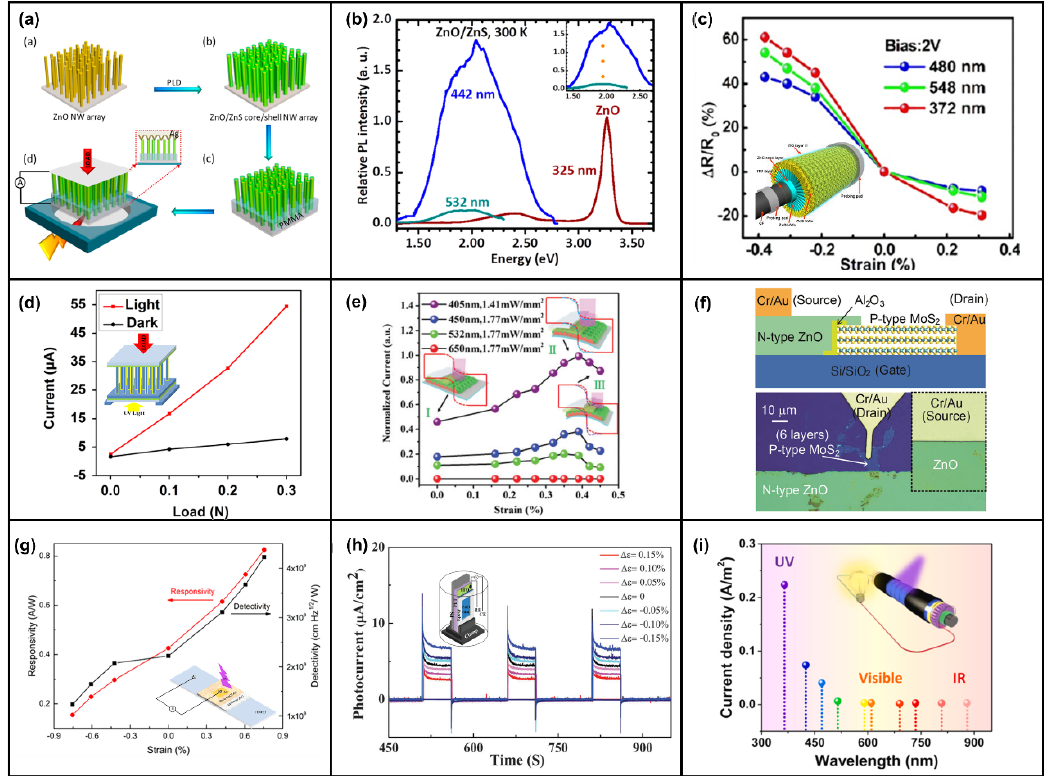
Figure 6. Device structure and characterization of photodetectors formed by Si/organic or other inorganic materials. ( a ) Schematic illustration of the ZnO/ZnS CS NW photodetector fabrication process. ( b ) Room-temperature PL for ZnO/ZnS core/shell NWs collected with comparable laser power ∼ 145 µ W under 532, 442, and 325 nm excitation, respectively. Inset: Magnification of the type-II transition PL peaks. The dotted orange line marks the broad peak center at ∼ 1.95 eV. Reproduced with permission from [166]. Copyright (2015) American Chemistry Society Nano . ( c ) Relative changes of responsivity. Inset: Schematic of a single carbon-fiber/ZnO-CdS wire-based photodetector. Reproduced with permission from [171]. Copyright (2013) American Chemistry Society Nano . ( d ) The plots of current at a fixed bias of 3.5 V as a function of pressure with/without illumination. Inset: Schematic diagram of the pressure sensor. Reproduced with permission from [175]. Copyright (2016) Nano Energy . ( e ) Photocurrent of the photodetector with different strains under 405 nm (1.41 mW/mm) and 450, 532, and 650 nm (1.77 mW/mm) illumination. Reproduced with permission from [178]. Copyright (2019) Nanoscale . ( f ) Side view of the schematic structure of the p-MoS2 and n-ZnO diode (top) and optical image of a typical device (bottom). Reproduced with permission from [189]. Copyright (2016) Advanced Materials . ( g ) Curves of calculated responsivity and detectivity as a function of applied strains, respectively. Inset: Schematic diagram of the device structure. Reproduced with permission from [192]. Copyright (2016) American Chemistry Society Applied Materials & Interfaces . ( h ) Photocurrent of the device under varying compressive and tensile strains at zero bias. Inset: A schematic of the device. Reproduced with permission from [194]. Copyright (2014) Physical Chemistry Chemical Physics . ( i ) Current densities of the photodetector under light illuminations with different wavelengths. Reproduced with permission from [195]. Copyright (2022) Nano Energy